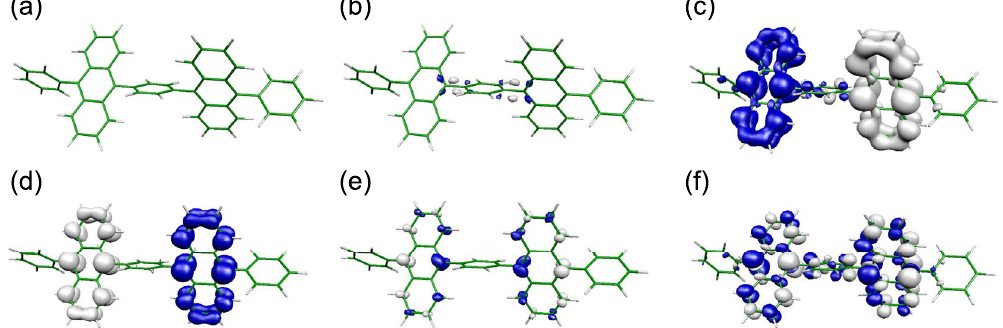
Figure 7. Overlap densities for ( a ) T 4 @T 4 –T 2 @T 4 , ( b ) T 4 @T 4 –T 1 @T 4 , ( c ) T 3 @T 3 –T 4 @T 3 , ( d ) S 2 @S 2 –S 1 @S 2 , ( e )